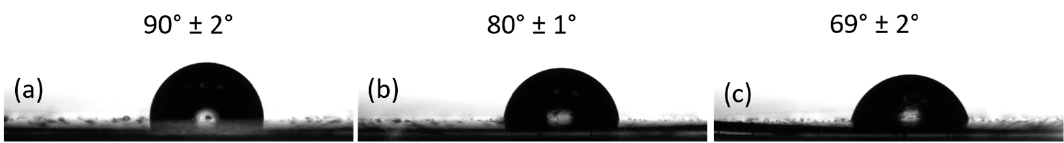
Figure 5. Contact angle images for ( a ) the uncoated working electrode, ( b ) the working electrode coated with a 25:75 %wt. PEDOT:PSS: GO pixel and ( c ) the working electrode coated with a 50:50 %wt. PEDOT:PSS: GO pixel transferred at 600 mJ/cm 2 .